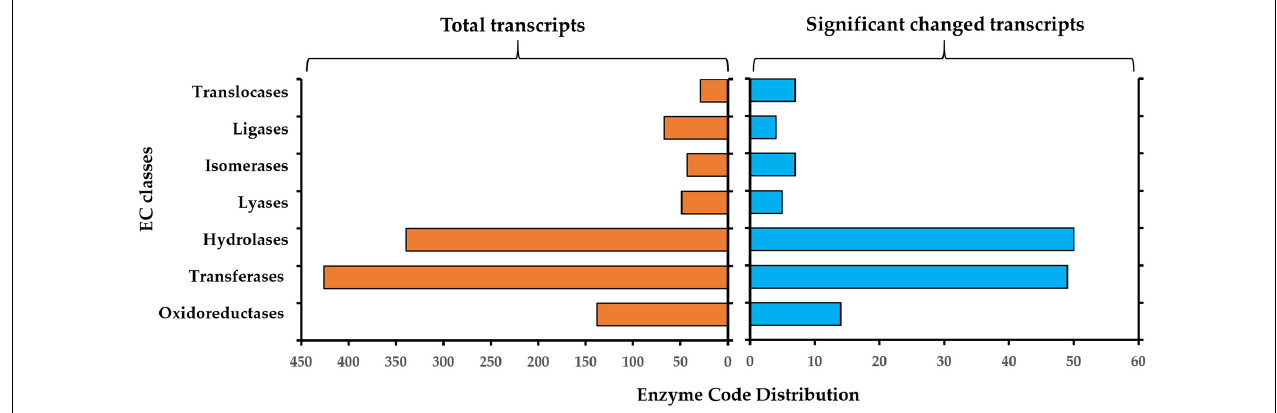
FIGURE 5 | Enzyme classification (EC) codes for the total (left) and significantly changed transcript (right) upon S. Subterranea spore germination. Note that one transcript can be associated with more than one EC term.